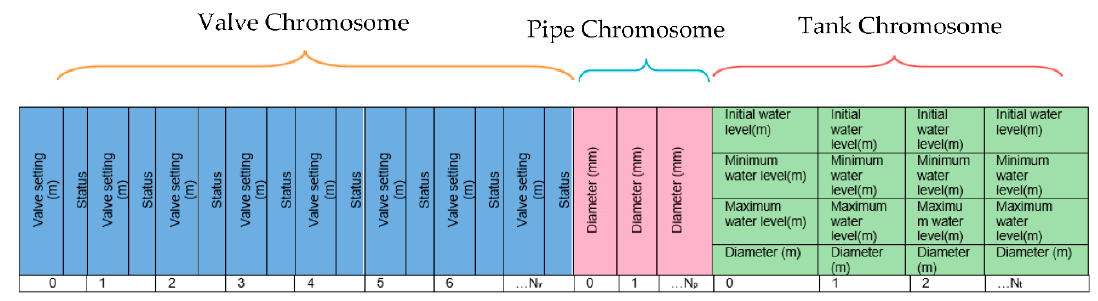
Figure 5. Representation of an individual from the FRM network.